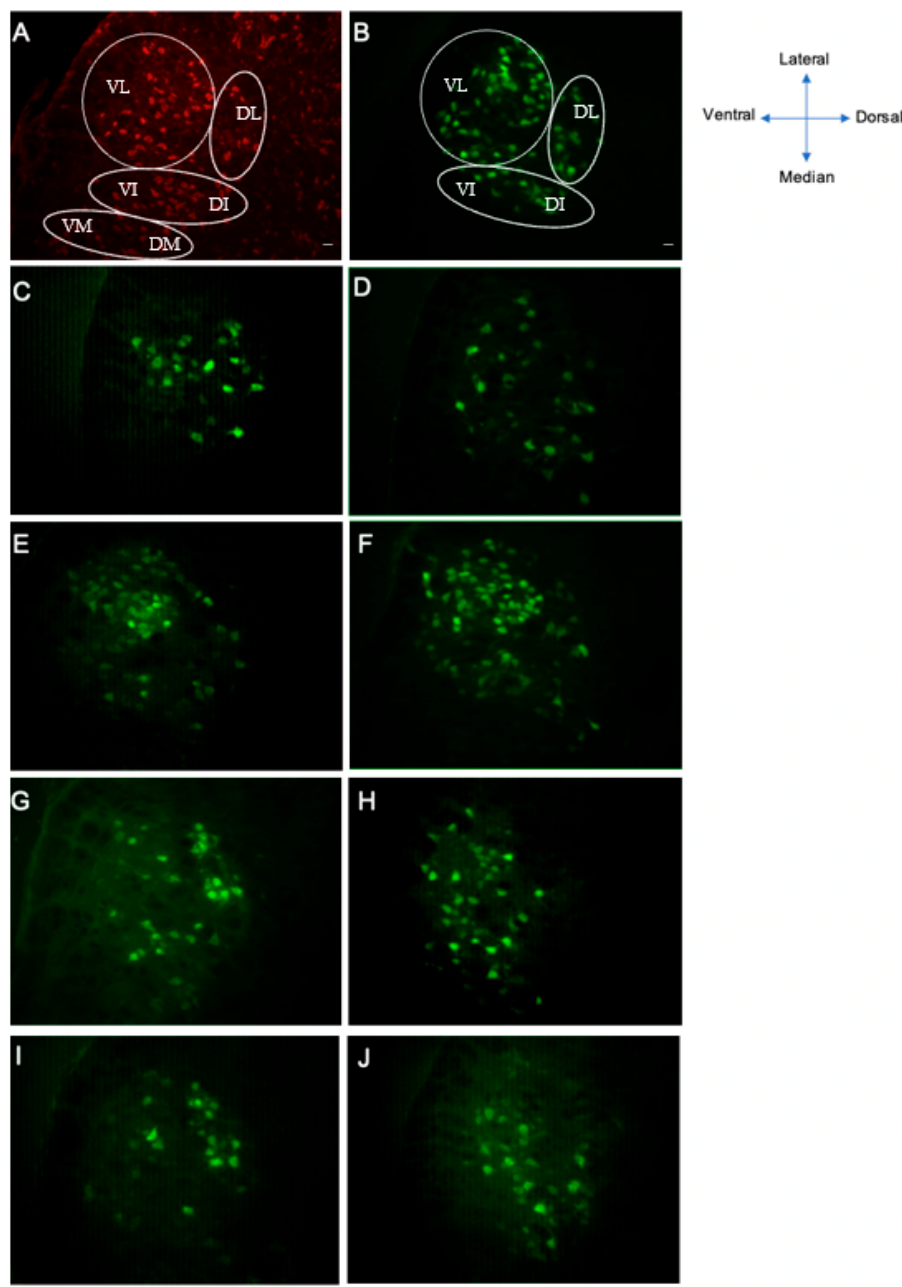
Figure 5. The precision of reinnervation 2 and 4 weeks after SS of the buccal and marginal mandibular branches of the facial nerve. ( A ) Nissl-like fluorescence counterstain “Neurotrace”; ( B ) FG retrograde labeling of facial motoneurons of the contralateral side (noninjured). ( C , D ) Facial nucleus after injection of FG into the whisker pads after surgery in control group; ( C ) 2 weeks after surgery and ( D ) 4 weeks after surgery. ( E , F ) Facial nucleus after injection of FG into the whisker pads in the BV -treated group; ( E ) 2 weeks after surgery and ( F ) 4 weeks after surgery. ( G , H ) Facial nucleus after injection of FG into the whisker pads in the bvPLA2 + melittin group; ( G ) 2 weeks after surgery and ( H ) 4 weeks after surgery. ( I , J ) Facial nucleus after injection of FG into the whisker pads in the betamethasone group; ( I ) 2 weeks after surgery and ( J ) 4 weeks after surgery. Retrograde labeling with Fluoro-Gold was confined to the lateral subnuclei with very few labeled cells at the intermediate subnuclei. VL, ventrolateral; DL, dorsolateral; VI, ventral intermediate; DI, dorsal intermediate; VM, ventromedial; DM, dorsomedial. Scale bar = 20 µ